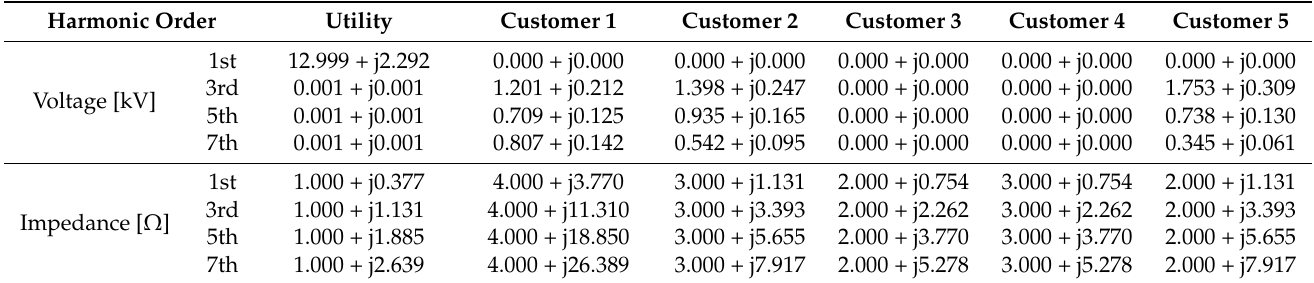
Table 1. The initial parameters of utility and the five customers.